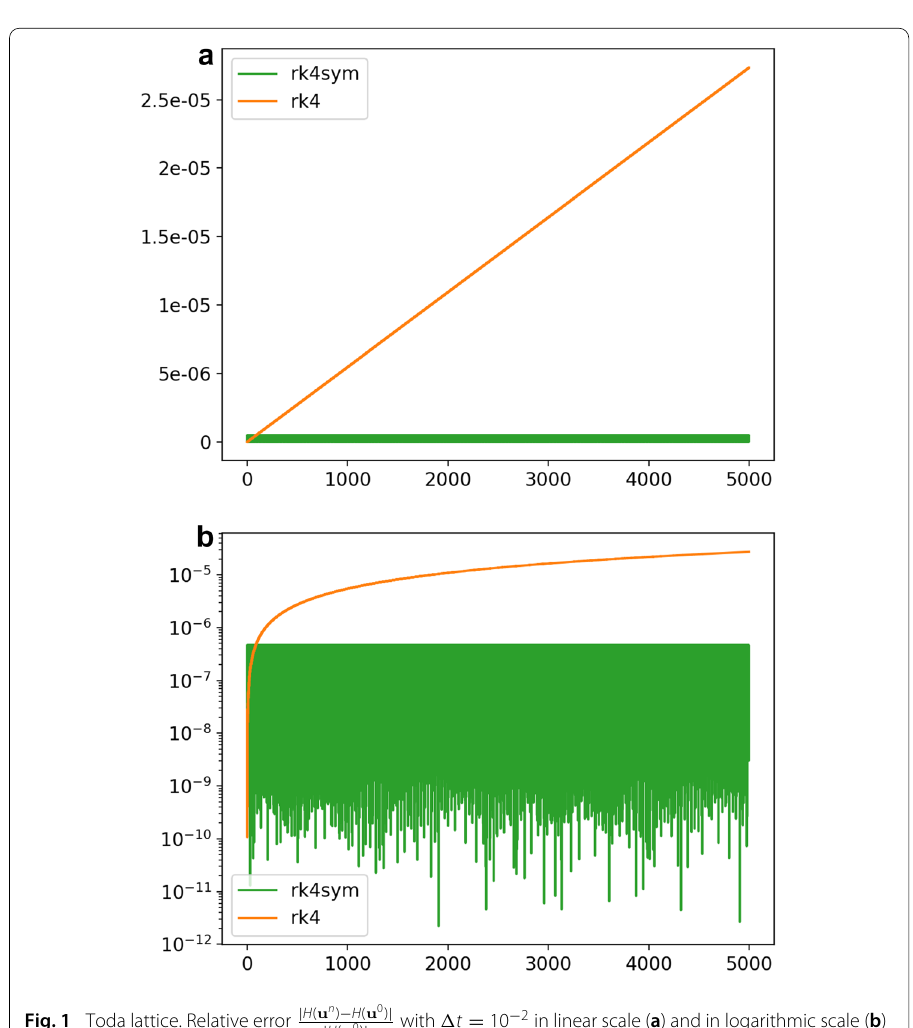
Fig. 1 Toda lattice. Relative error | H ( u